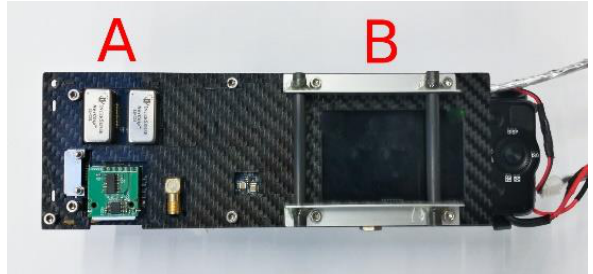
Figure 3. Camera sensor head; A – Redundant IMU, B – Sony NEX 5R